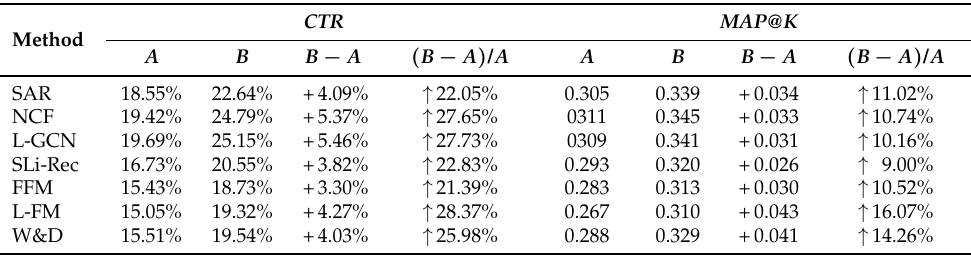
Table 3. The results of A/B experiments for evaluative information on the Tweetings dataset ( A : w/o rating; B :